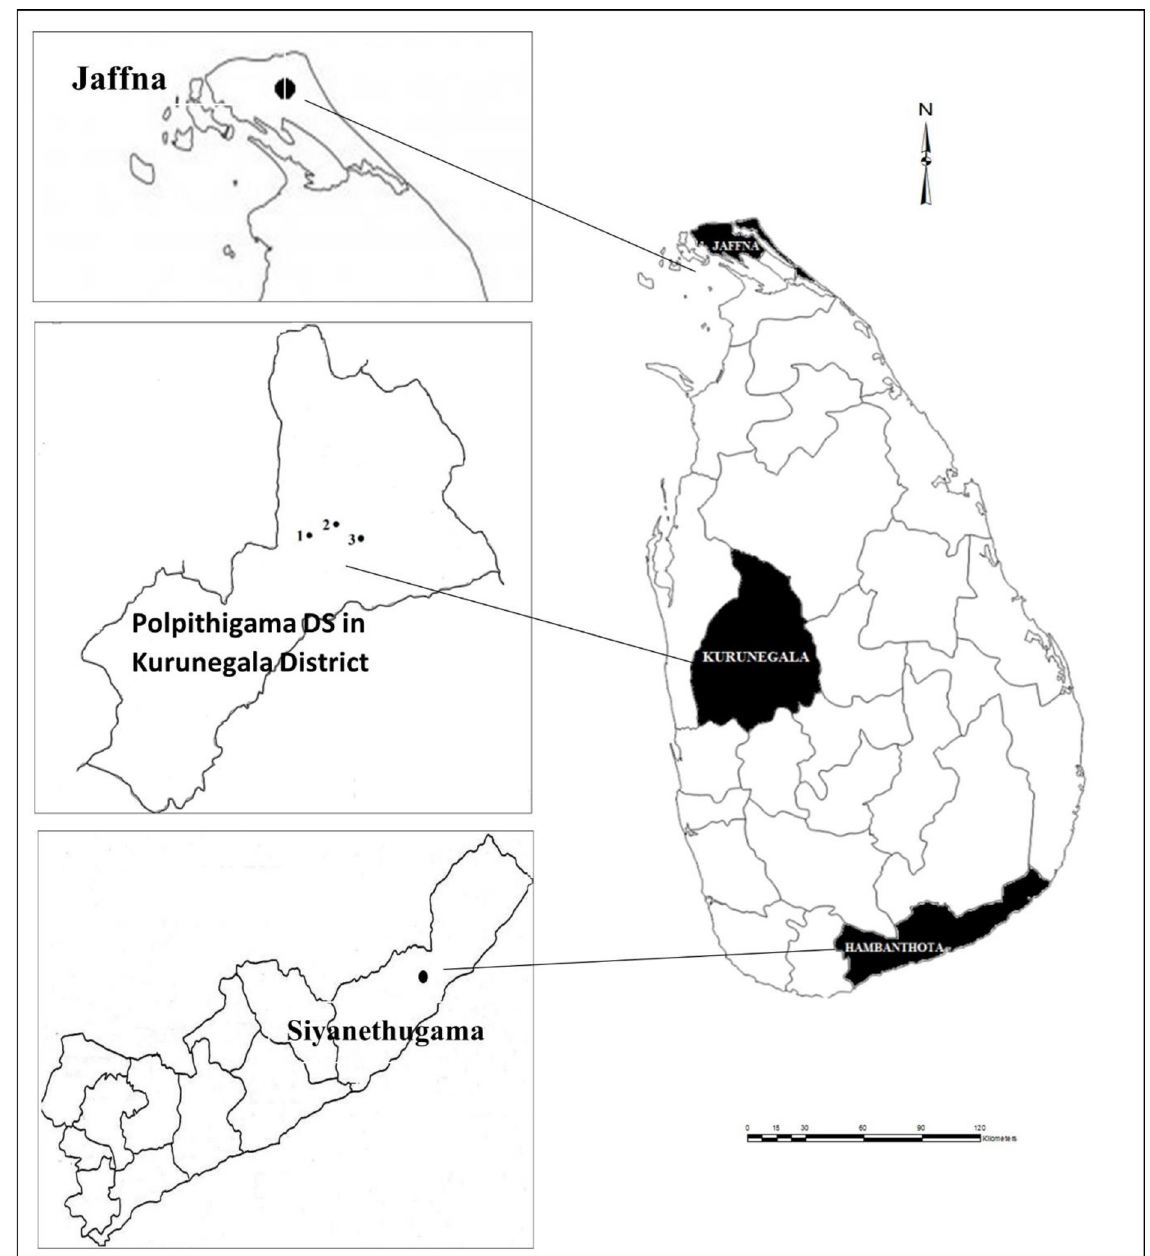
Fig 1. District allocation of VIB individuals. Source: Authors’ demonstration using